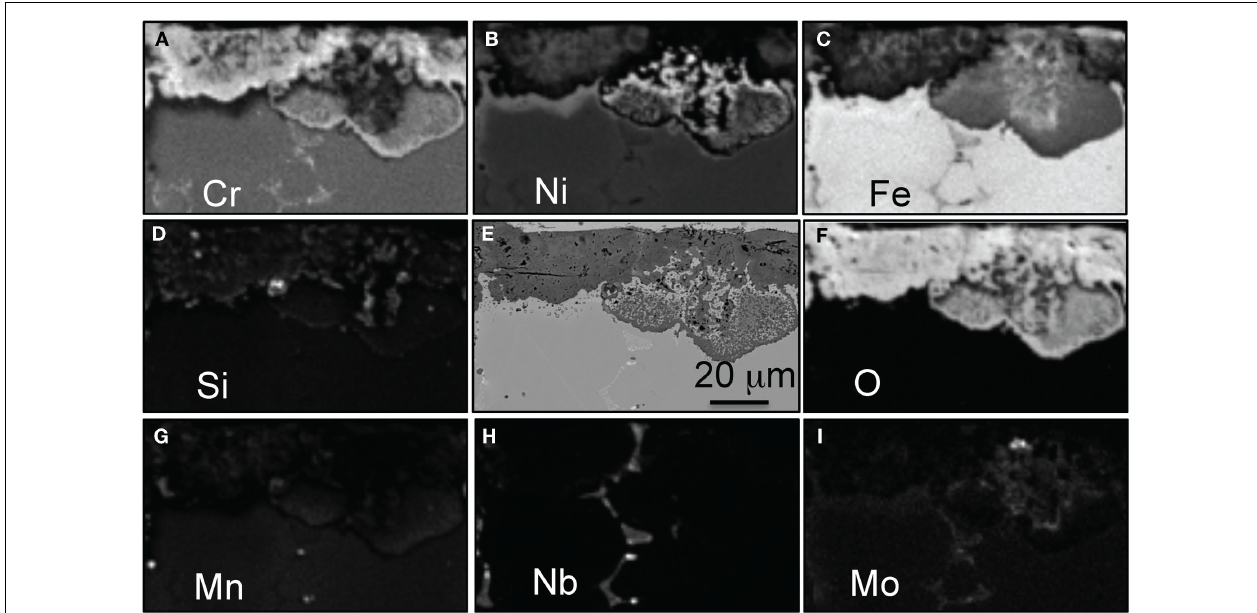
FIGURE 12 | EPMA mapping for alloy CF8CP exposed for 1000h in air +++ 10% H 2 O at 800°C, (A) Cr, (B) Ni, (C) Fe, (D) Si, (E) SEM picture, (F) O, (G) Mn, (H) Nd, and (I) Mo .